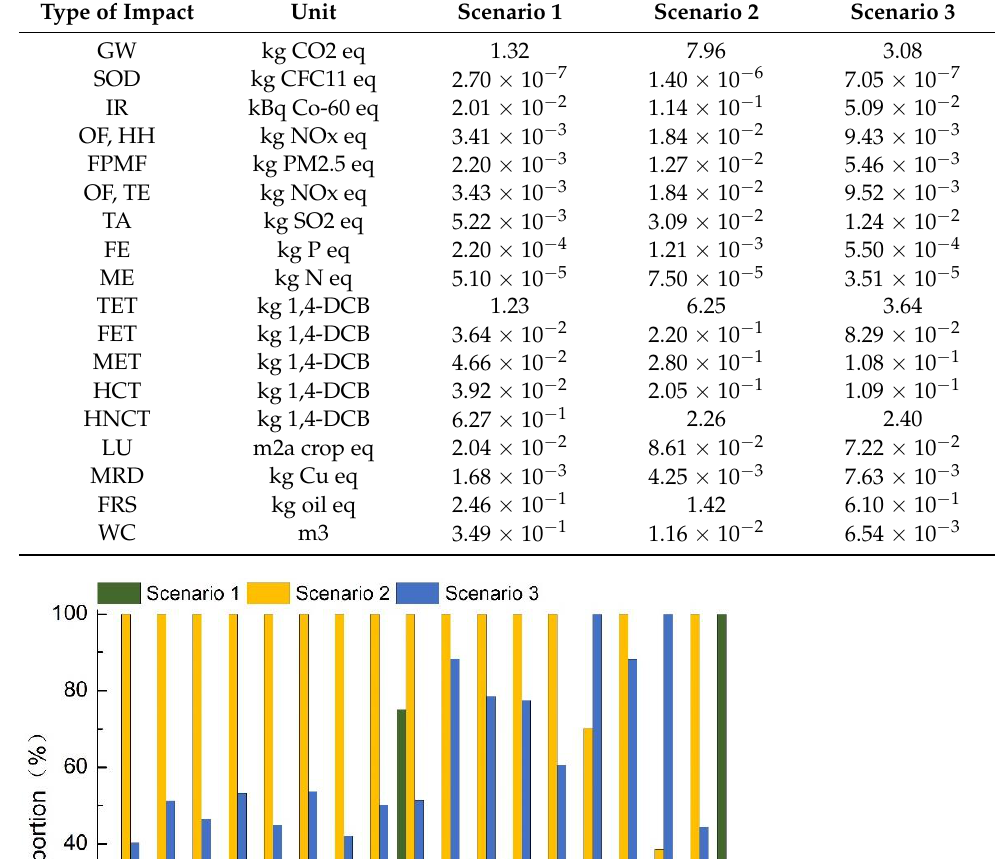
Table 3. Normalized LCA results of tailings discharge schemes.